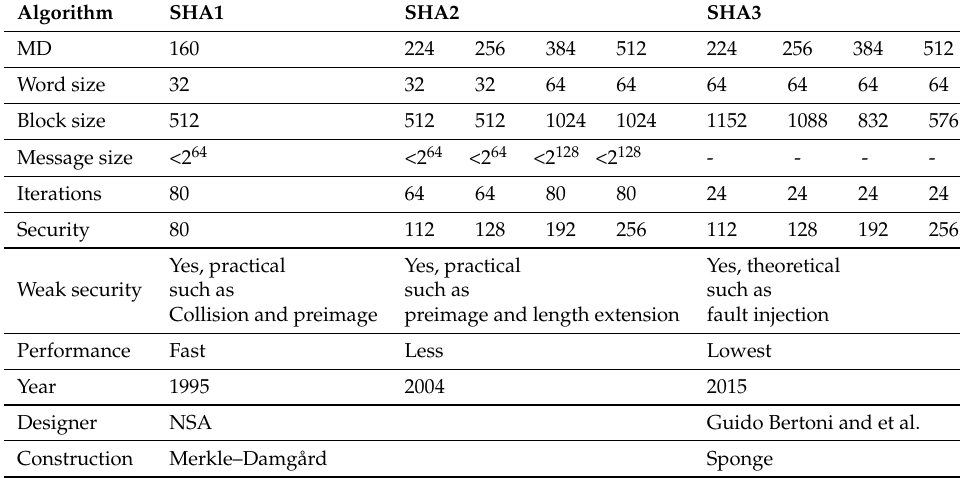
Table 1. Comparison of SHA